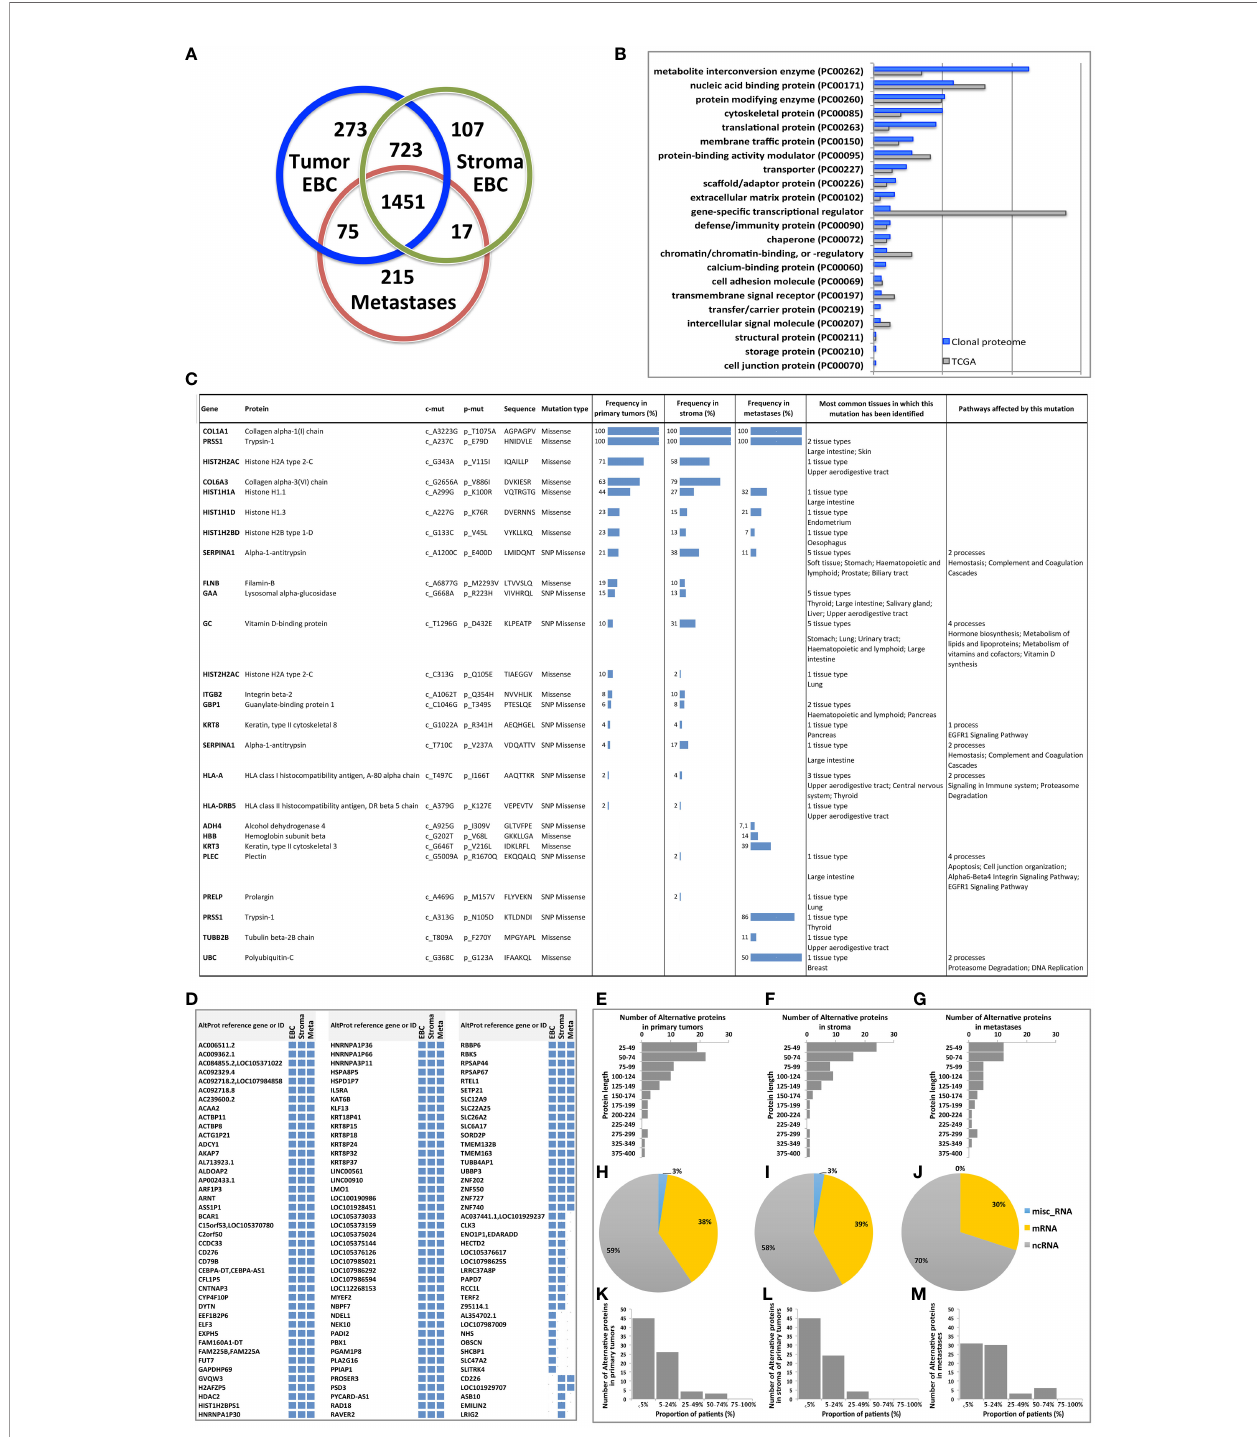
FIGURE 2 | (A) The Venn diagram showing the number of proteins speci fi c or shared among primary tumors (blue), stroma (green) and metastases (red). (B) Distribution of protein classes (in %) in the clonal proteome dataset (in blue) compared with TCGA dataset (in grey). (C) Mutated proteins identi fi ed using mass spectrometry, with their frequency in primary tumors, stroma and metastases, and the tissues in which they have been reported, along with the processes they affected. (D) 126 Alternative proteins identi fi ed by mass spectrometry; their length is indicated in (E) primary tumor samples, (F) stroma samples and (G) metastases. Their coding RNA distribution is shown in (H – J) , respectively. The frequency of alternative proteins among patients is shown in (K) primary tumors, (L) stroma and (M) metastases. AltProt, alternative proteins; EBC, early breast cancer; ID, identi fi cation; Meta, metastases; SNP, single nucleotide